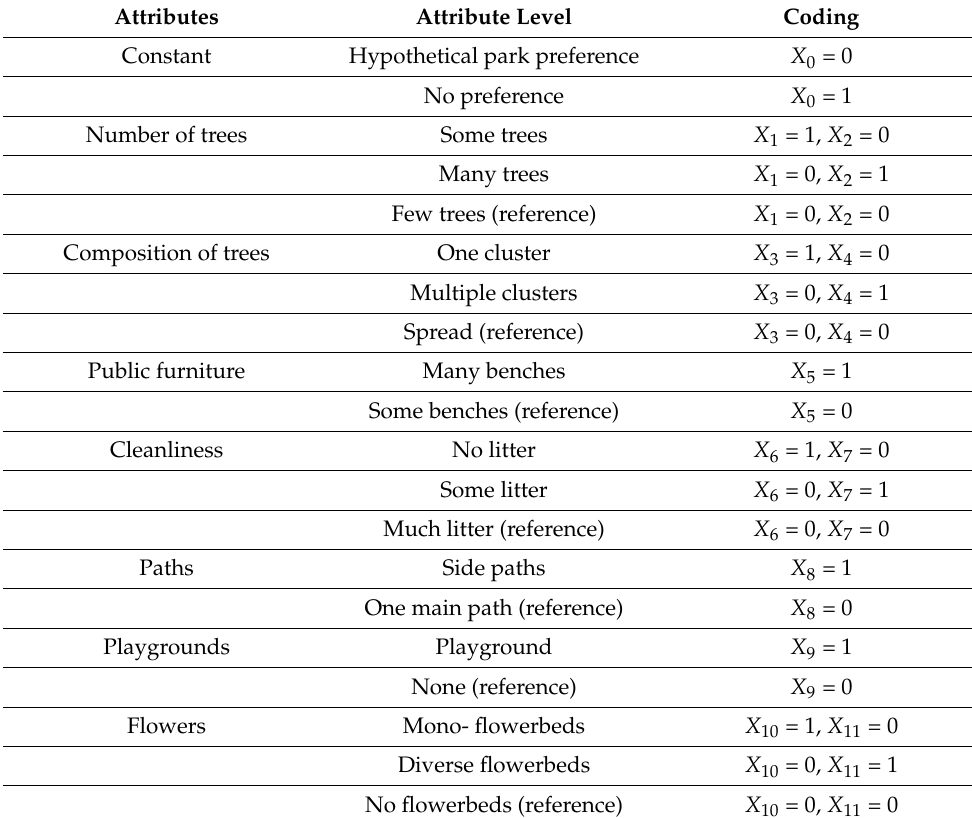
Table 2. Coding of attribute